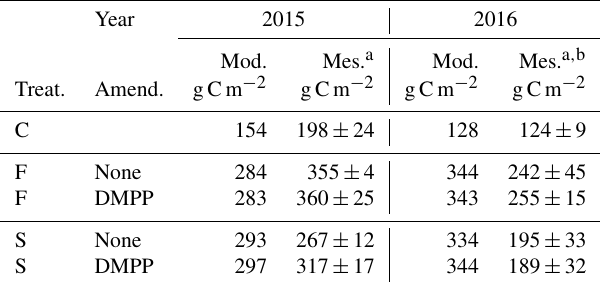
Table 8. Barley silage yields modelled and measured without slurry (C) or with slurry applied in fall (F) or spring (S) with and without NI applied on dates in the field study (Table